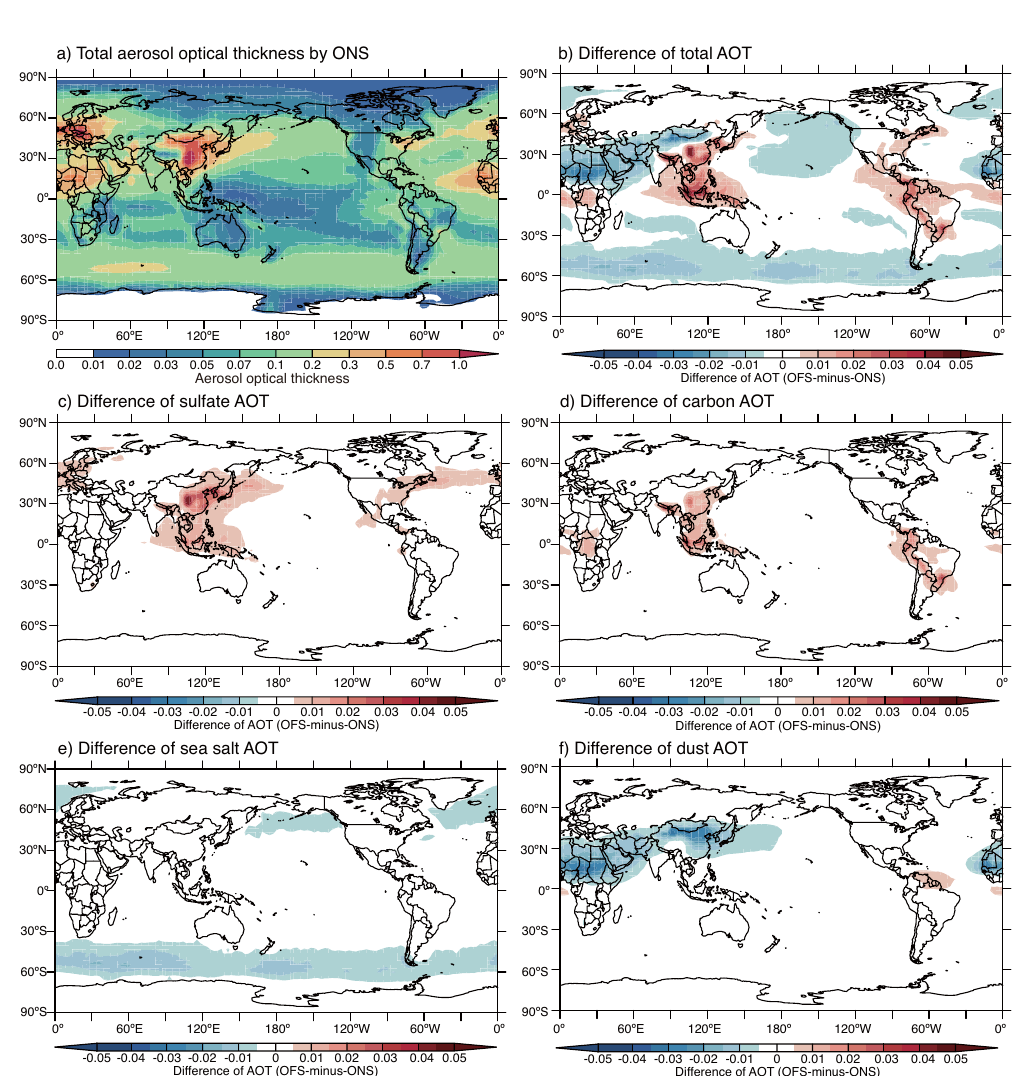
Fig. 3. Spatial distributions of annual averaged AOT and deviations (OFS minus ONS). (a) total AOT by ONS and deviations for (b) total, (c) sulfate, (d) carbon, (e) sea-salt, and (f) dust AOTs.